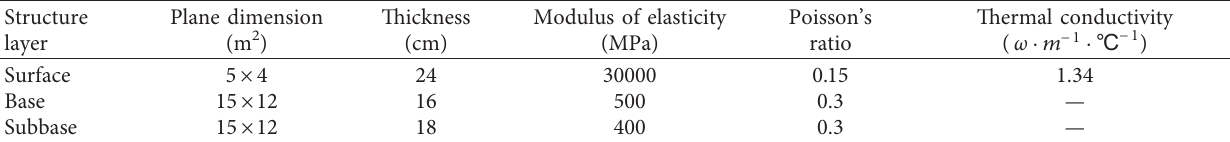
Table 2: Material parameters of each structure layer of cement concrete pavement.